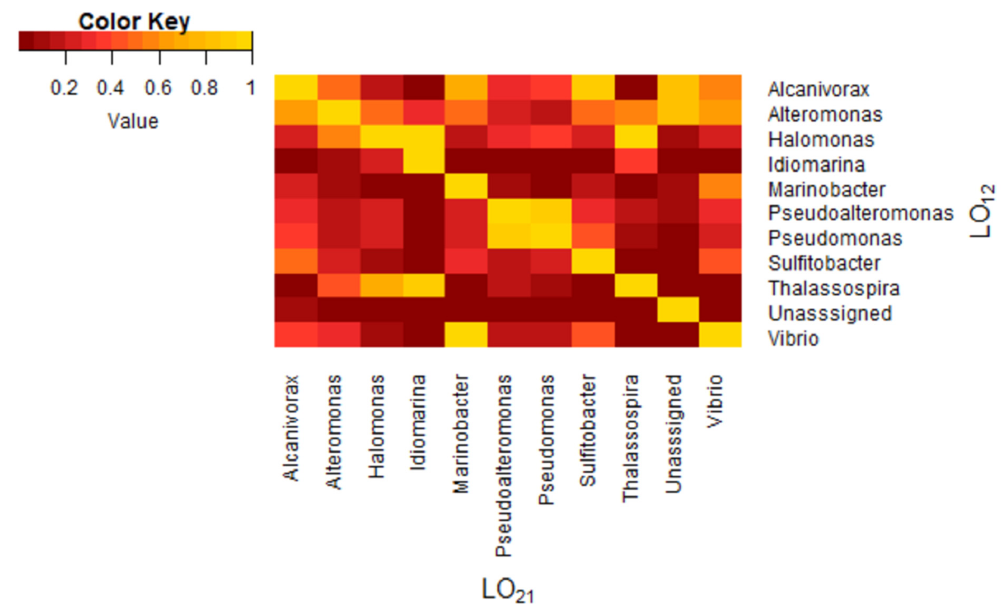
Figure 6. Heatmap of Levin’s Overlap (LO) indicating coexistence of species taking into account their environmental distribution in the three different treatments (Deep14, Deep25 and Surface25). Only taxa that pass the LOQ line are included. The scale bar shows values between 0 for poor overlap (dark red) and 1 for complete overlap (yellow).